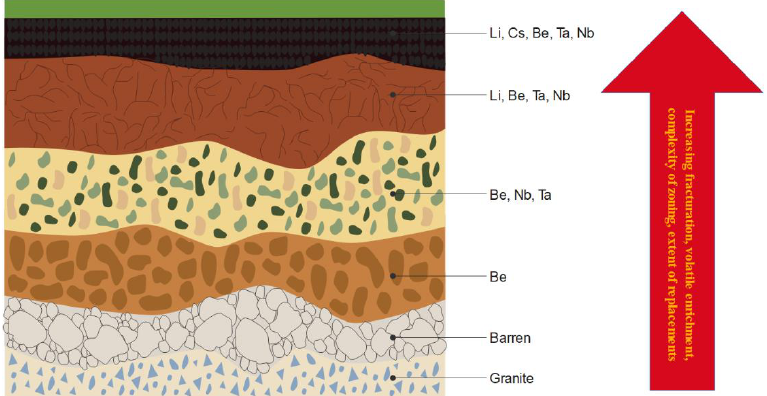
Figure 3. Chemical evolution through a lithium-rich pegmatite group with distance from the granitic source [28] (adapted with permission from the Mineralogical Association of Canada, Granitic Pegmatites in Science and Industry; published by the Mineralogical Association of Canada, 2019).